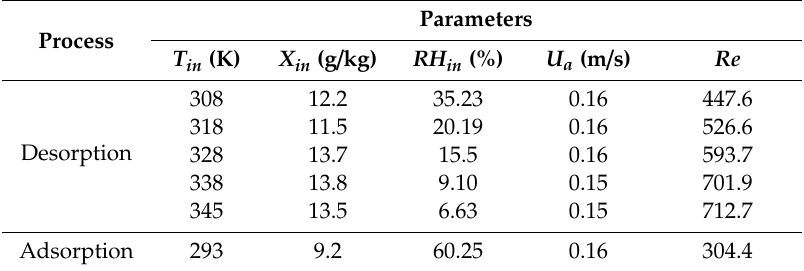
Table 2. Experimental conditions of the desiccant dehumidification system. T in : Temperature inlet, X in : Humidity ratio inlet, RH in : Relative humidity inlet, U a : air velocity, Re : Reynolds number.